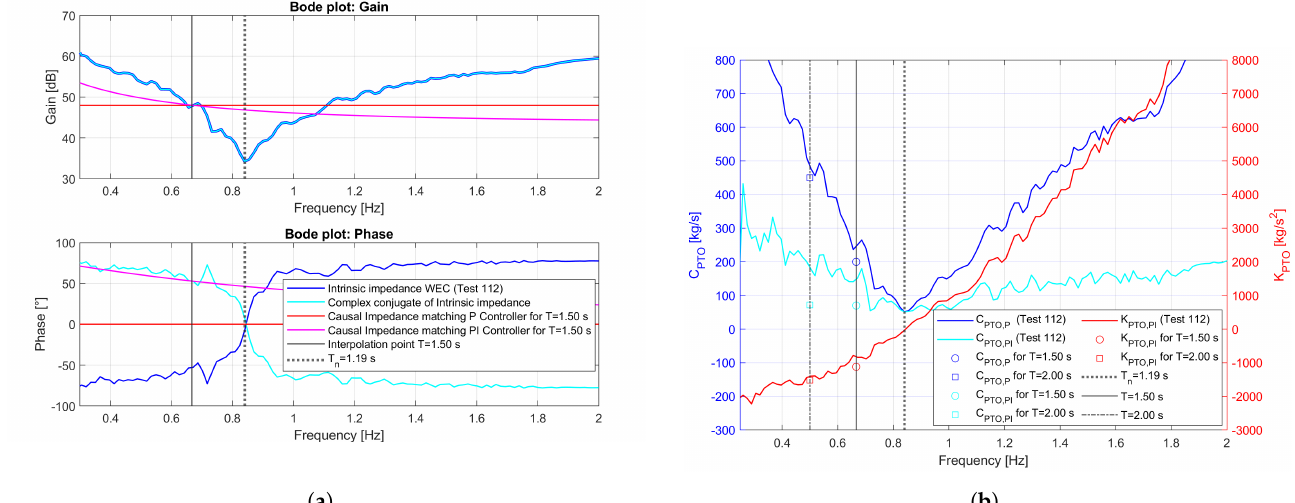
Figure 18. Radiation Test_112: ( a ) Bode plot intrinsic impedance and causal impedance matching P and PI controller; ( b ) Coefficients causal impedance matching P and PI